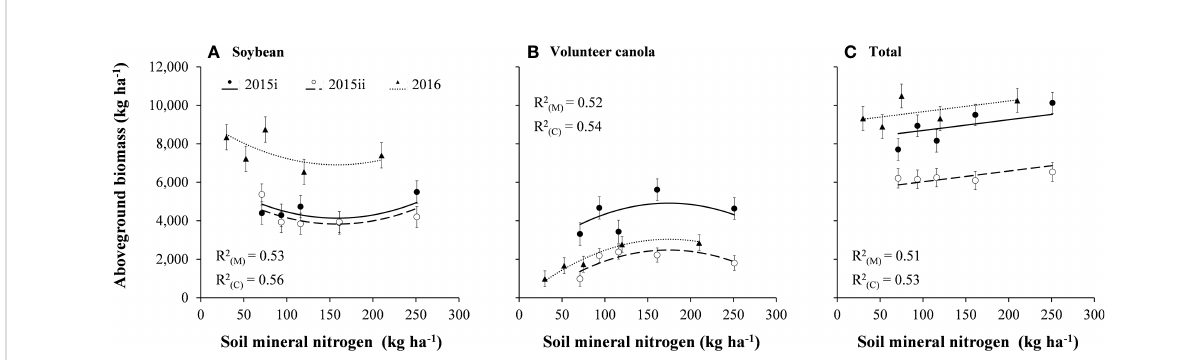
FIGURE 4 Aboveground biomass of (A) soybean, (B) volunteer canola, and (C) soybean plus volunteer canola (total) in response to soil mineral nitrogen in the 2015i, 2015ii, and 2016 environments. Dots indicate means of aboveground biomass at each level of soil mineral nitrogen in each environment in a combined analysis of volunteer canola populations. Error bars indicate ± SEM. All linear and/or quadratic components were signi fi cantly different from 0 ( a = 0.05). Marginal (R 2 (M) ) and conditional (R 2 (C) ) coef fi cients of determination are indicated for the entire linear mixed effects model. All model parameters are described in Supplementary Table